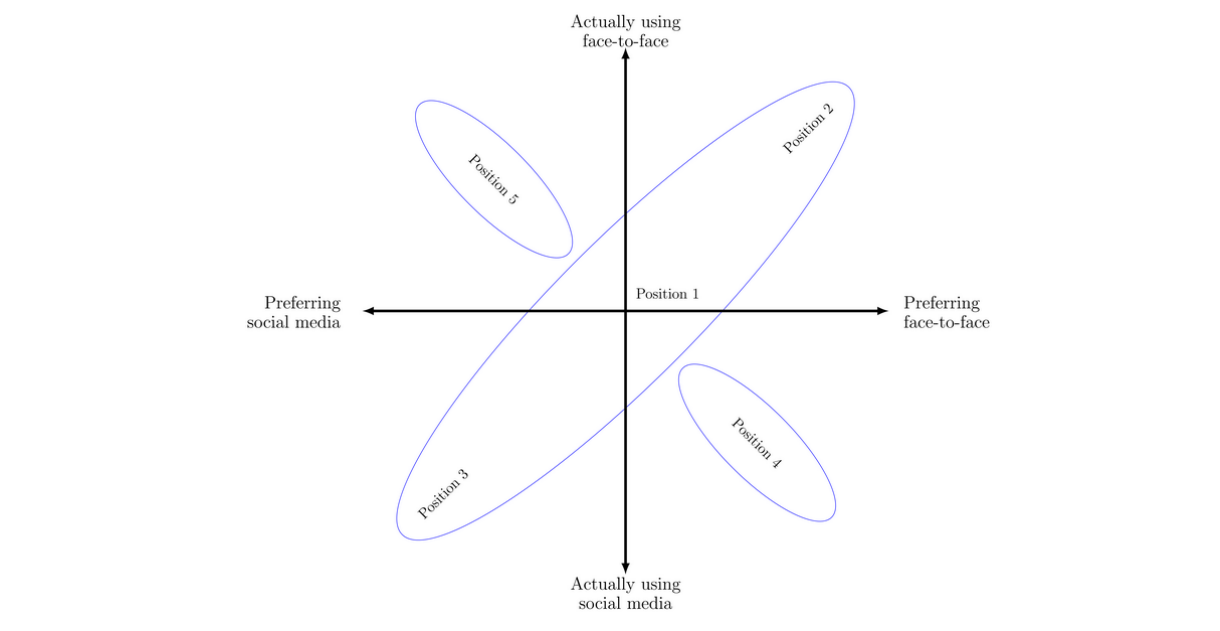
Figure 1. Youth social interaction positions.